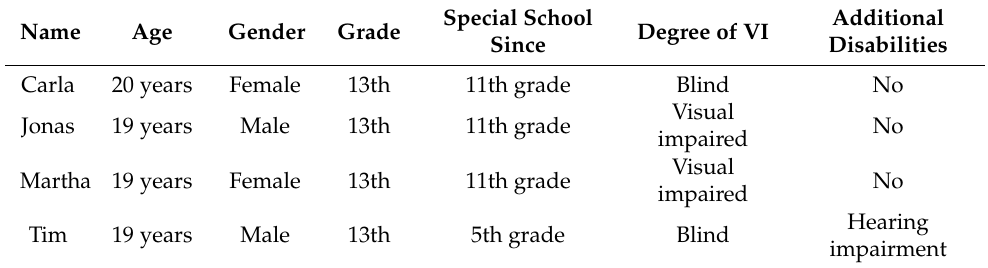
Table 1. Characteristics of the respondents (on the date of the